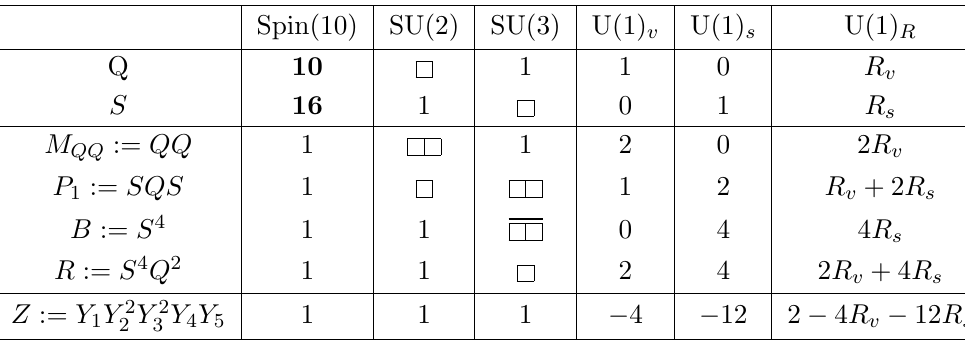
Table 13 . 3d N = 2 Spin(10) theory with ( N v ; N s ; N s 0 ) = (2 ; 3 ; 0).